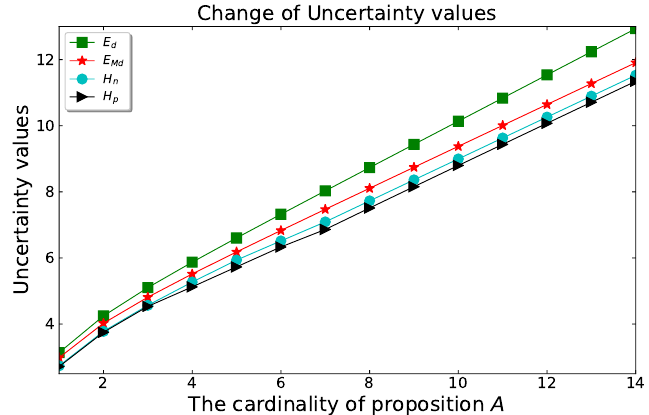
Figure 7. The change of uncertainty values in Example